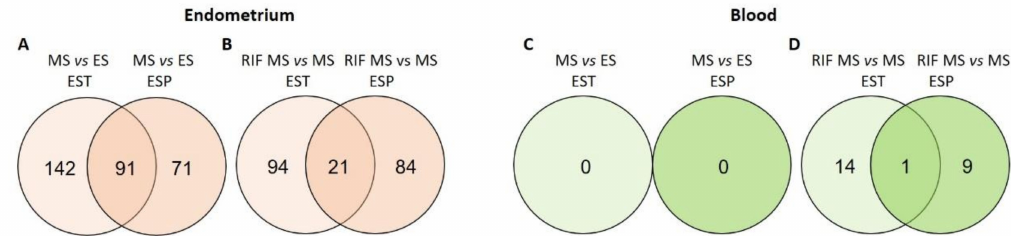
Figure 2. Number of differentially expressed miRNAs in EST and validation cohort ESP in ( A ) MS vs. ES phase endometrial samples of fertile women; ( B ) MS phase endometrial samples from infertile recurrent implantation failure (RIF) patient vs. fertile women; ( C ) MS vs. ES phase blood samples of fertile women; and ( D ) MS phase blood samples from RIF patients vs. fertile women. EST - Estonian samples; ESP—Spanish samples; RIF—recurrent implantation failure; ES—early secretory phase; MS—mid-secretory